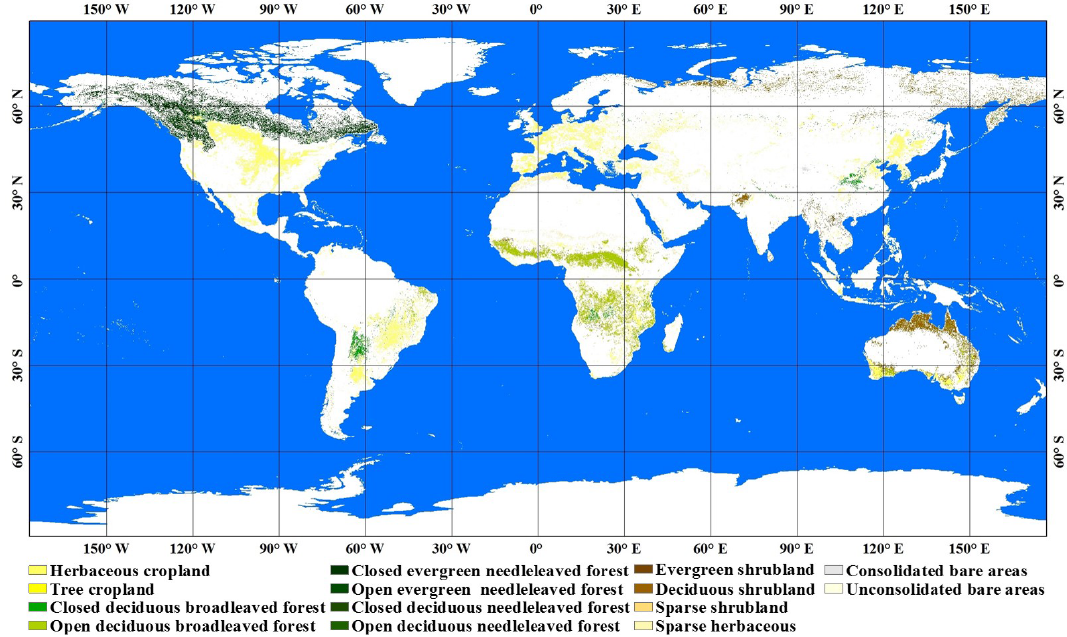
Figure 12. The spatial distributions of 14 detailed regional land-cover types in the GLC_FCS30-2015 products.